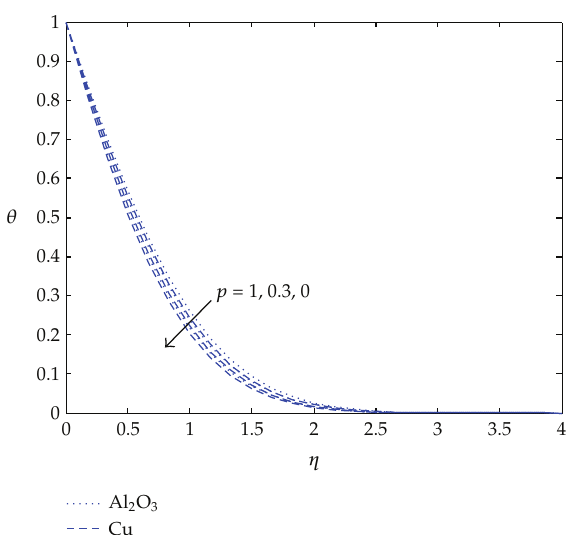
Figure 4: Variation of dimensionless temperature for di ff erent values of parameter p (cid:5) Pr (cid:8) 6 . 2, ψ (cid:8) 0 . 1, m (cid:8) 1, ξ (cid:8) 0 . 1, ∧ (cid:8) 0 . 1 (cid:6) .